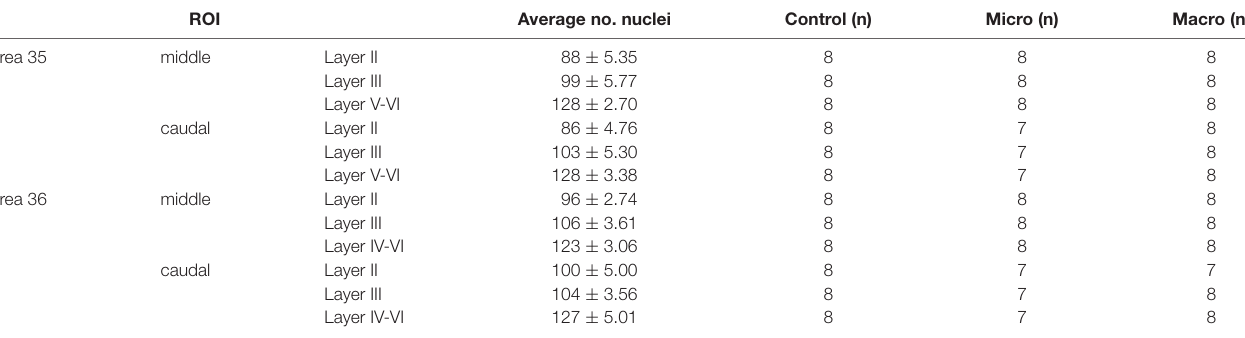
TABLE 1 | Overview of the number of nuclei (mean ± standard deviation) analyzed for each image of each region of interest (ROI) for the layers of the middle and caudal PRC areas 35 and 36, as well as the number of animals (n) used in each group. ROI Average no.